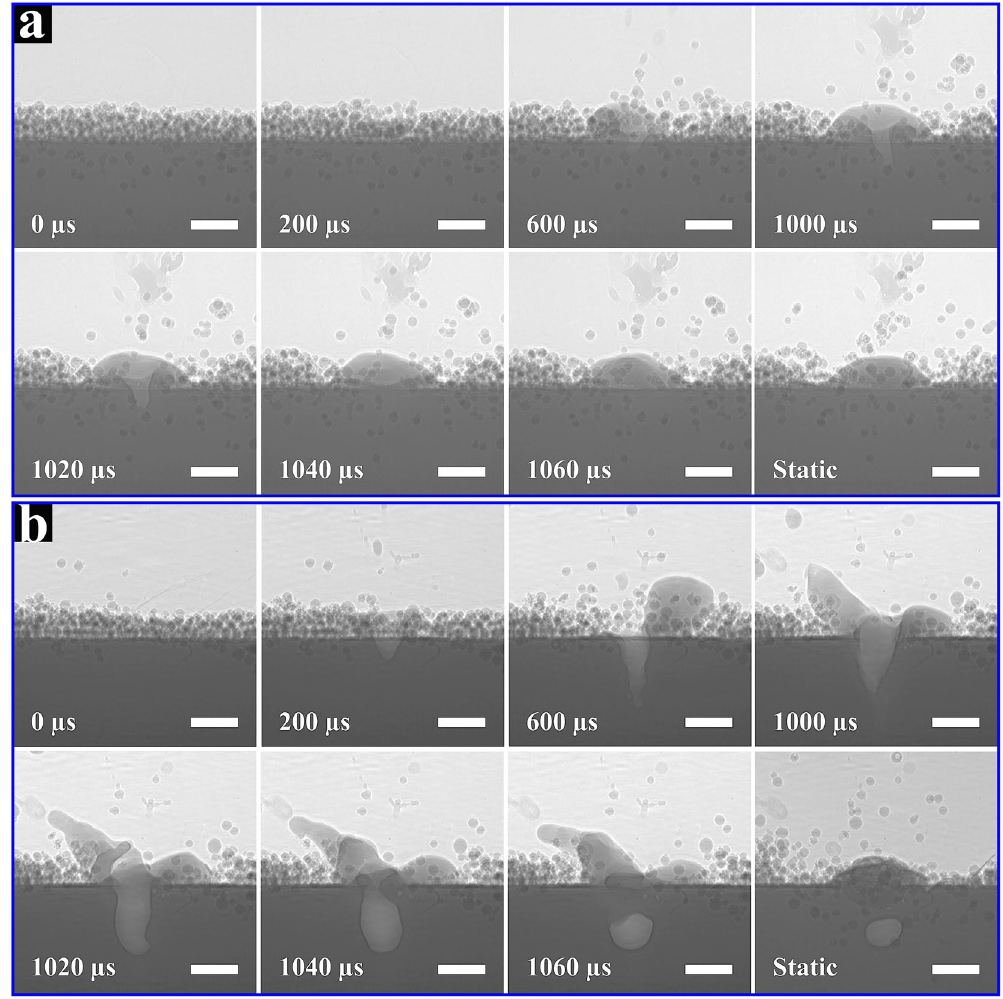
Figure 2. Dynamic X-ray images of laser powder bed fusion processes of Ti-6Al-4V. The laser powers are 340 W for image group ( a ) and 520 W for group ( b ), respectively. The laser beam size is ~220 µ m (1/e 2 ). The powder particle size is in the range of 5–45 µ m, and the powder layer thickness is ~100 µ m. The numbers indicate the time nodes. The laser is turned ON at t = 0, and continues to heat the sample till t = 1000 µ s. The raw data were taken with a frame rate of 50 kHz. The exposure time for each individual image is 350 ns. All the scale bars are 200 µ